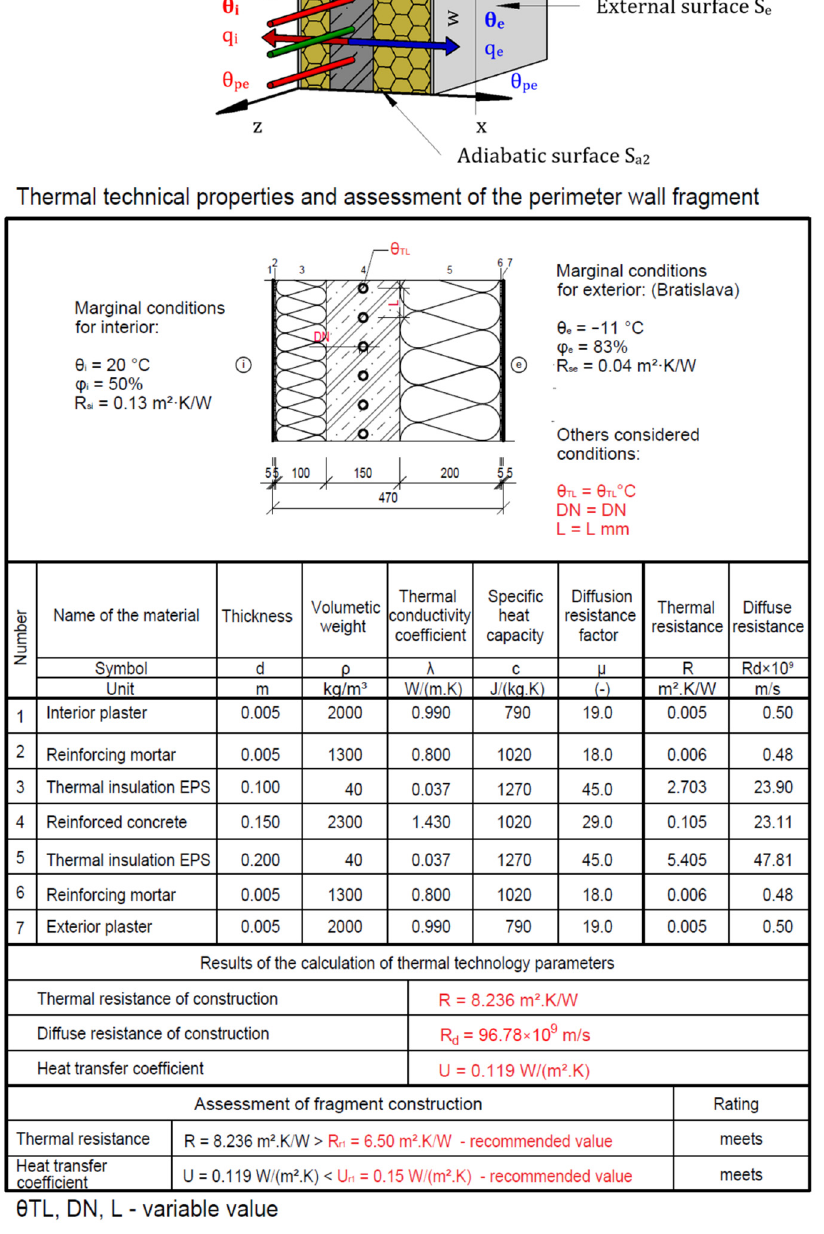
Figure 7. Mathematical–physical model: composition of an upgraded thermal insulation envelope